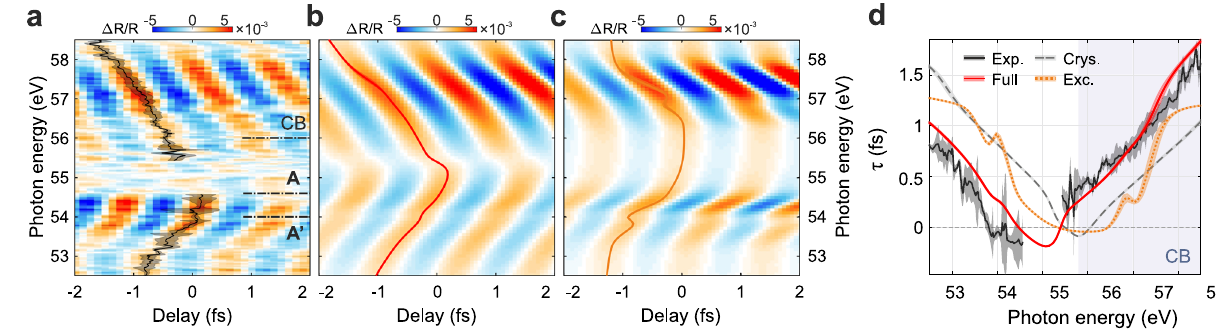
Fig. 3 Core-exciton dynamics on an attosecond time scale. a Fast component of the experimental Δ R / R . The phase delay, τ , between the oscillations and E 2 is displayed in black. The solid curve represents the mean over four independent measurements and the shaded area twice its standard deviation. b , c IR Same as ( a ) but for the full or the pure exciton calculation results, respectively. d Comparison between the experimental (black solid) and calculated τ , considering the full system response (red solid), or addressing separately the crystal (grey dashed) and excitonic (orange dotted) contributions.